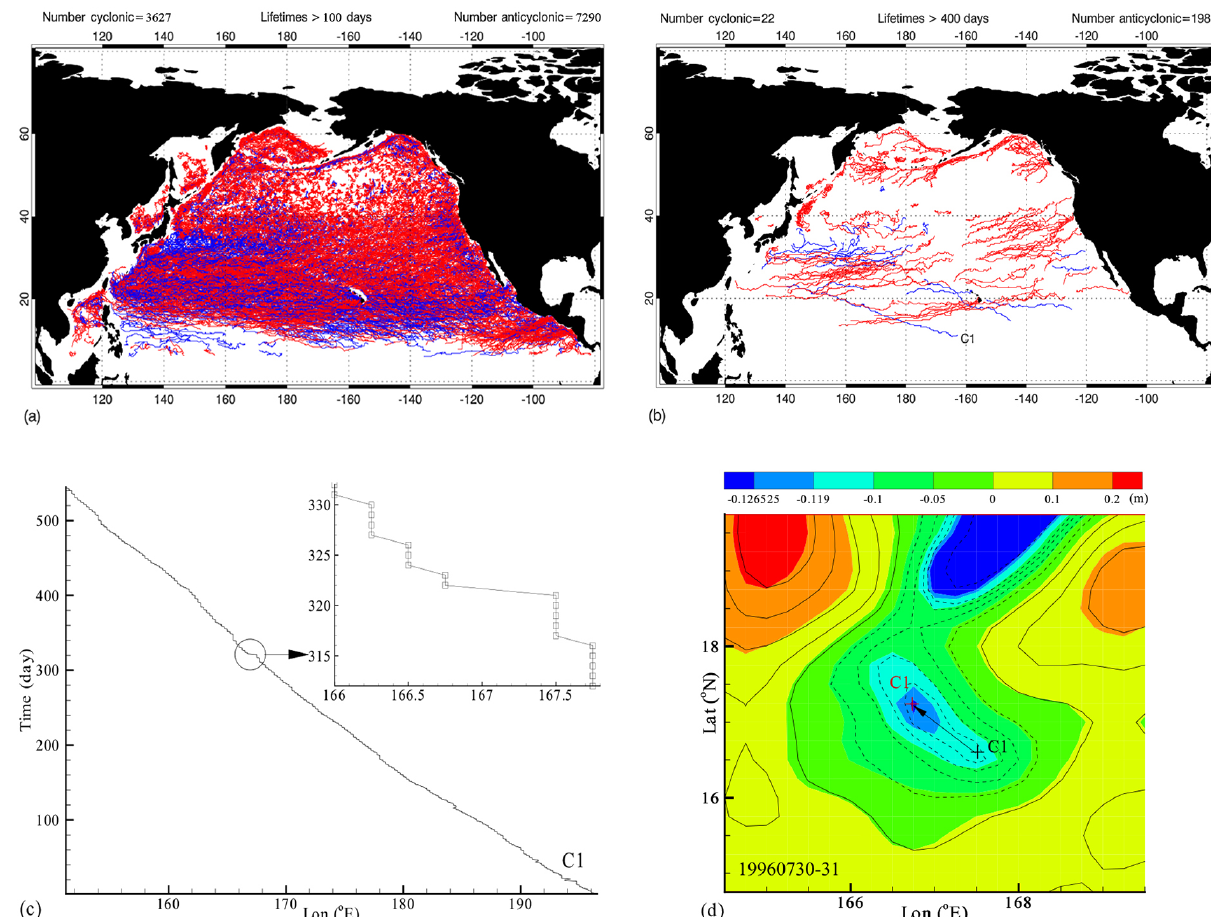
Figure 10. (a) Tracks of long-lived (>100 days) eddies. (b) Tracks of long-lived (>400 days) eddies. In (a) and (b) , blue color marks cyclonic eddies, and red color marks anticyclonic eddies. (c) The track of eddy C1. Note the sudden jump from 167.5 to 166.75 ◦ E on 31 July 1996. (d) The SLA fields on 30 (contours) to 31 July (shading), using the same intervals for the contours and the shadings. The eddy centers are marked by a black cross (30 July) and a red cross (31